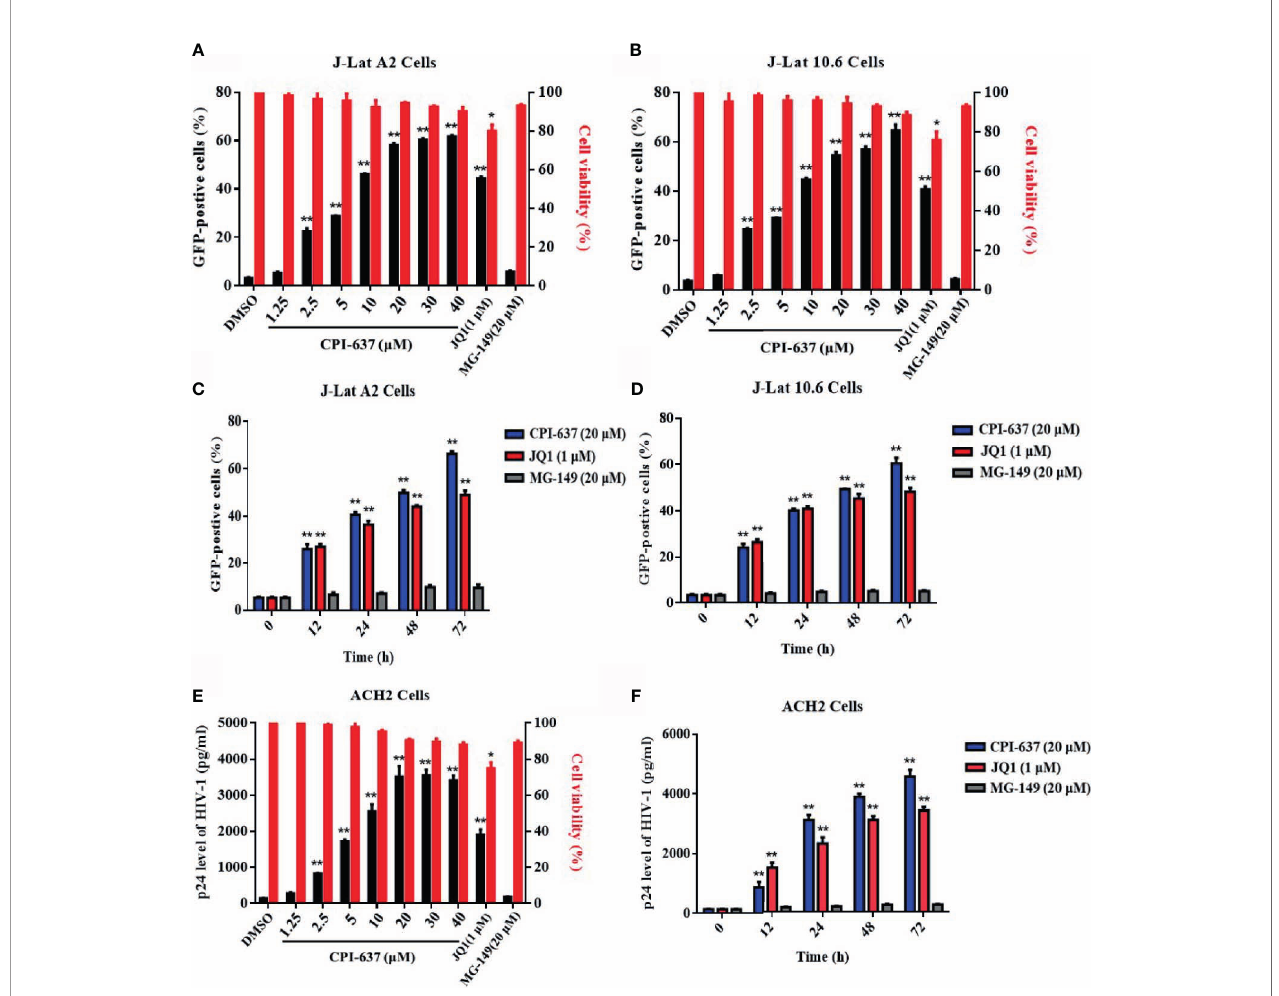
FIGURE 1 | CPI-637 induces HIV-1 expression in latently infected cell lines in vitro . J-Lat A2 and J-Lat 10.6 cells were treated with CPI-637 for 48 h at the indicated concentrations (A, B) or with CPI-637 (20 m M) at the indicated time points (C, D) . And the percentage of GFP-positive cells within the entire population, representing the level of HIV-1 transcription (A – D) , was measured by fl ow cytometry and the cell viability (A , B) was detected by MTT assay, respectively. ACH2 cells were treated with CPI-637 at the indicated concentrations (E) or the indicated time points (F) . HIV-1 p24 antigen expression (E , F) was detected by ELISA and the cell viability (E) was detected by MTT assay, respectively. (* p < 0.05 vs DMSO control group, ** p < 0.01 vs DMSO control